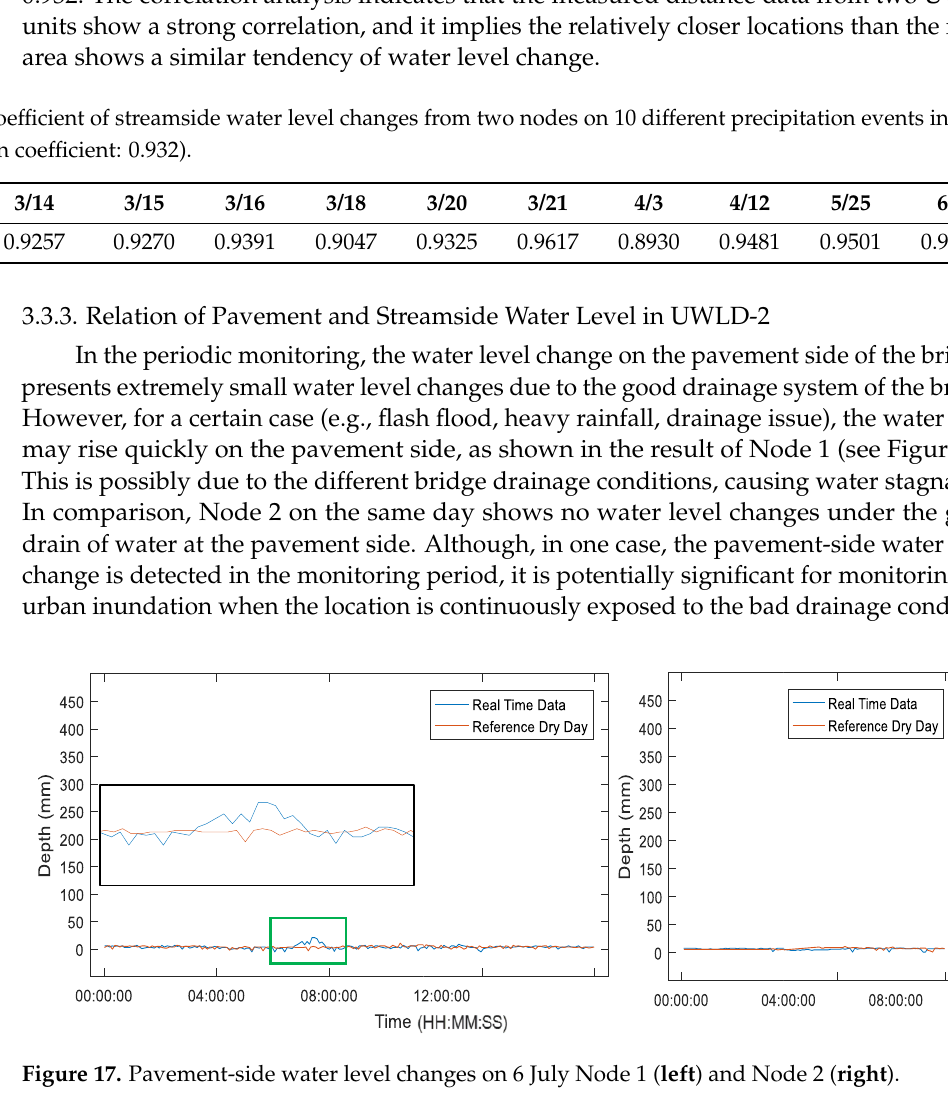
Table 1. The correlation coefficient of streamside water level changes from two nodes on 10 different precipitation events in 2020 (averaged correlation coefficient: 0.932).